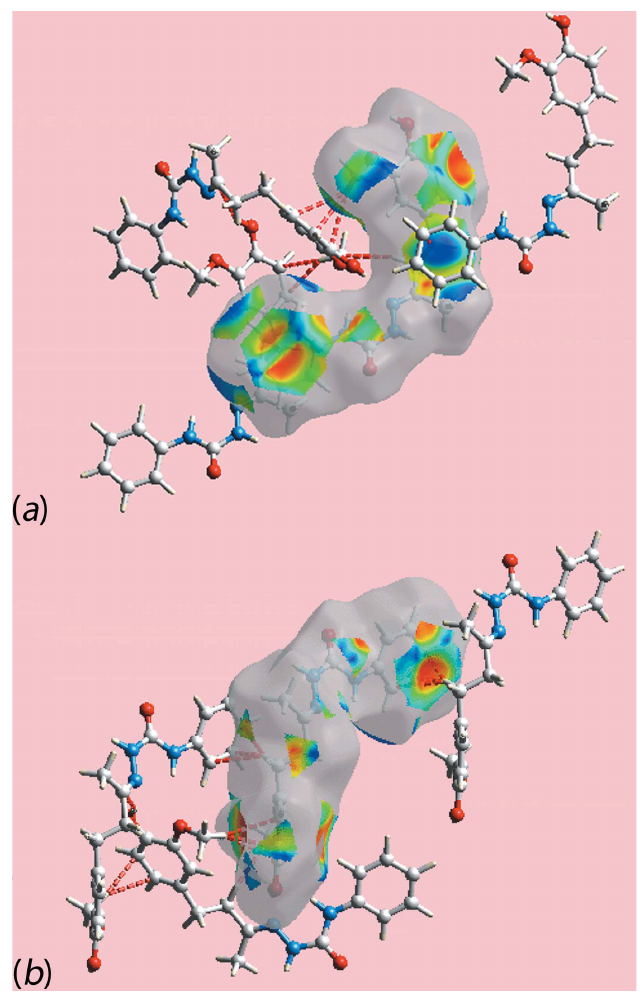
Figure 6 Views of the shape-indexed Hirshfeld surfaces about reference molecules highlighting dominant short interatomic C—H/H—C and C—H (cid:3)(cid:3)(cid:3) (cid:2) / (cid:2) (cid:3)(cid:3)(cid:3) H—C interactions for the ( a ) O1-containing molecule and ( b ) the